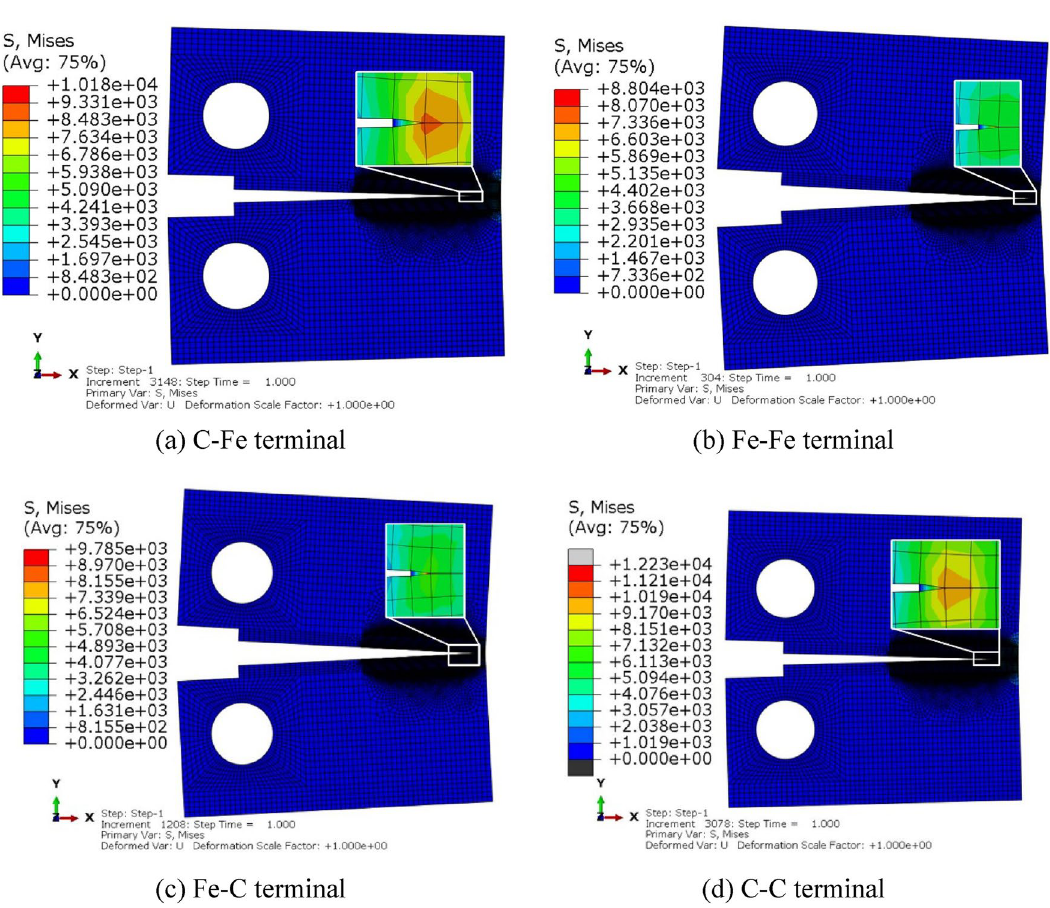
Figure 20. Stresses cloud diagram of different terminal with model size of 250 μm × 240